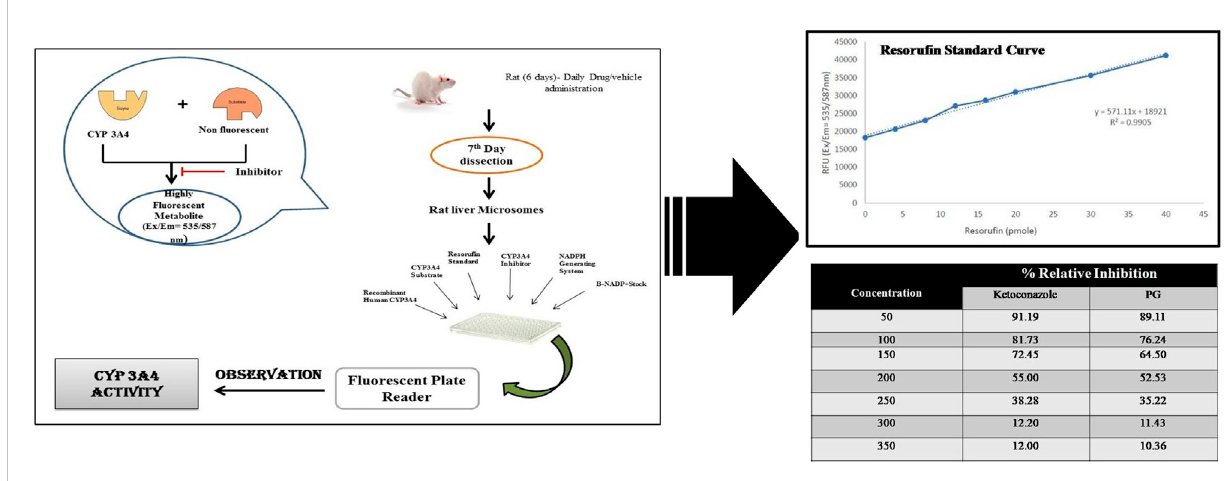
FIGURE 10 CYP3A4 percentage inhibitory activity of test compounds, positive control, and negative